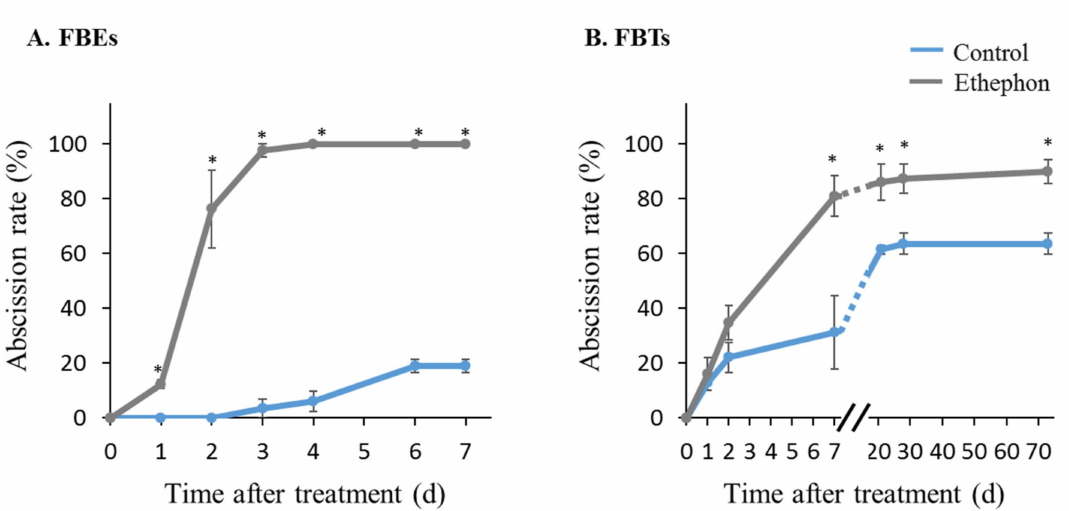
Figure 2. Effect of ethephon treatment on rates of mango fruitlet abscission in fruitlet-bearing explants (FBE) ( A ) and fruitlet-bearing trees (FBT) ( B ). ( A ) Fruitlet abscission was induced with ethephon using three experimental units of FBE, each composed of 110–120 explants. Three untreated experimental units served as controls. The number of intact fruitlets in each experimental unit was monitored at several time intervals, and abscission rates were calculated. Values represent the means + SE of three biological replicates. ( B ) Four trees were sprayed with ethephon to induce abscission, and four control trees were sprayed with surfactant alone. The number of intact fruitlets in each tagged panicle was monitored at several time intervals, and abscission rates were calculated. Values represent means + SE of 60 counts (15 panicles X 4 trees per treatment). Asterisks (*) denote significant differences between ethephon-treated and control explants or trees at each sampling point ( p ≤ 0.05).